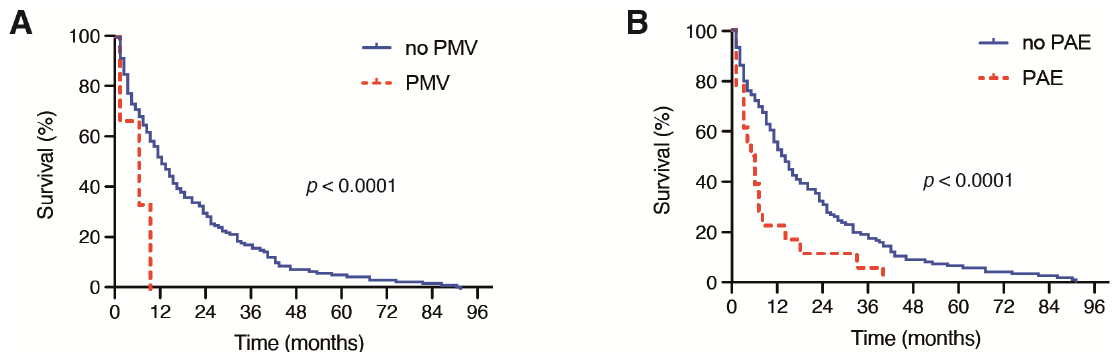
Figure 3. Kaplan–Meier survival curves depicting the influence of ( A ) PMV (>48 h) and ( B ) the development of PAE on the OS in patients with BM derived from NSCLC. BM: brain metastases; CRP: C-reactive protein; NSCLC: non-small cell lung cancer; OS: overall survival; PAE: perioperative adverse events; PMV: prolonged mechanical ventilation.